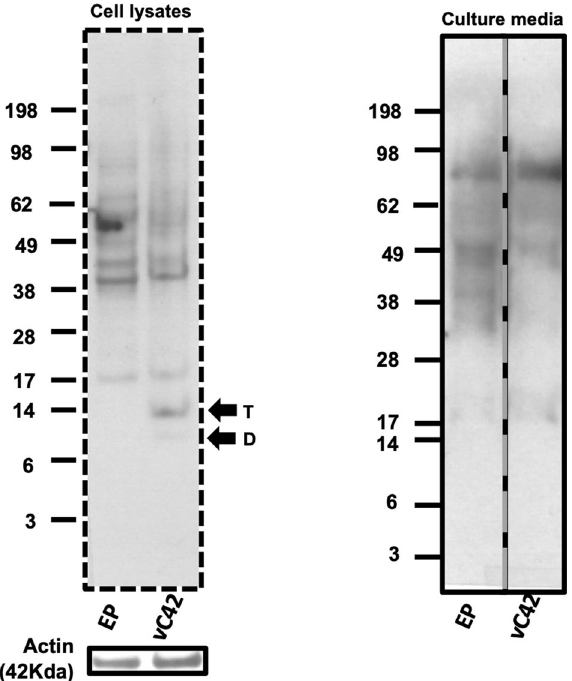
Figure 3. Hexamer formation is directly related to Aβ42 self-assembly propensity. CHO cells transfected with vC42 (F19S, G37D), did not form hexameric Aβ in either the cell lysates or media detected by the W0-2 antibody. However, dimers (D) and trimers (T) were detected in the cell lysates of vC42 transfected CHO cells. Actin (42 kDa) loading controls are provided for the cell lysates conditions. Vertical dashed lines indicate that samples were run on the same gel, but lanes are not contiguous. Dashed border indicates the membrane was cut before detection. A full-length gel image of the media samples is presented in Supplemental Figure